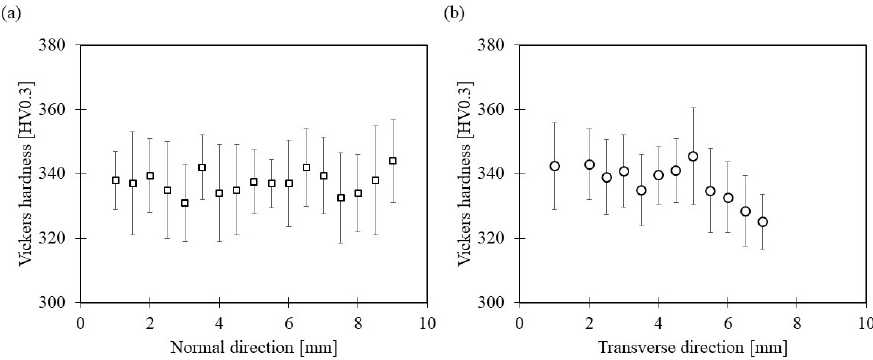
Figure 6. Hardness measurements in WAAM-processed Ti-6Al-4V in ( a ) normal and ( b ) transverse directions. The hardness is slightly changing due to the microstructure changes within the layer transition zones.